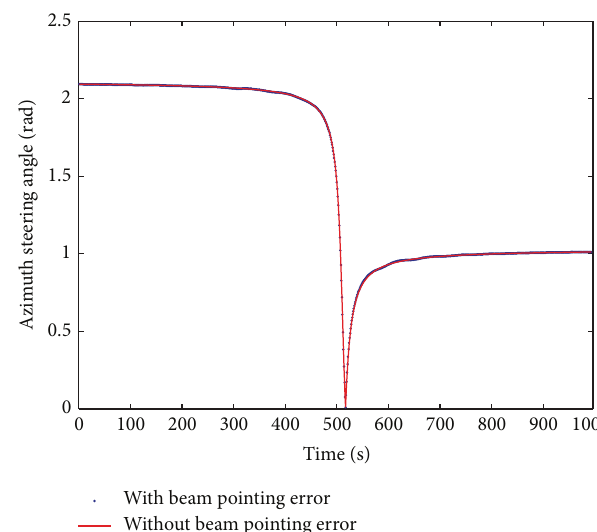
Figure 16: Estimation error of 𝛼 - 𝛽 - 𝛾 filter with 𝑔 𝑟,1 = 𝑔 𝑝,1 = 𝑔 2 = 0.75